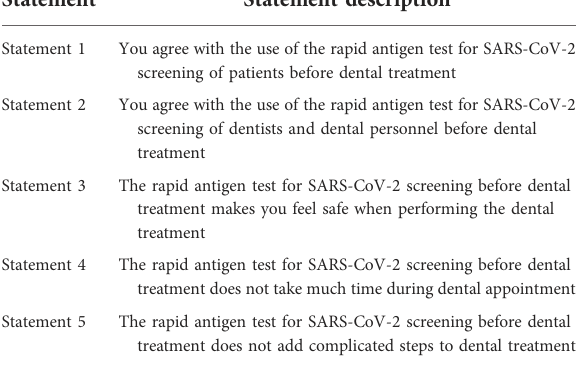
TABLE 2 Demographic characteristics of cases at the Center for SARS- CoV-2 Rapid Antigen